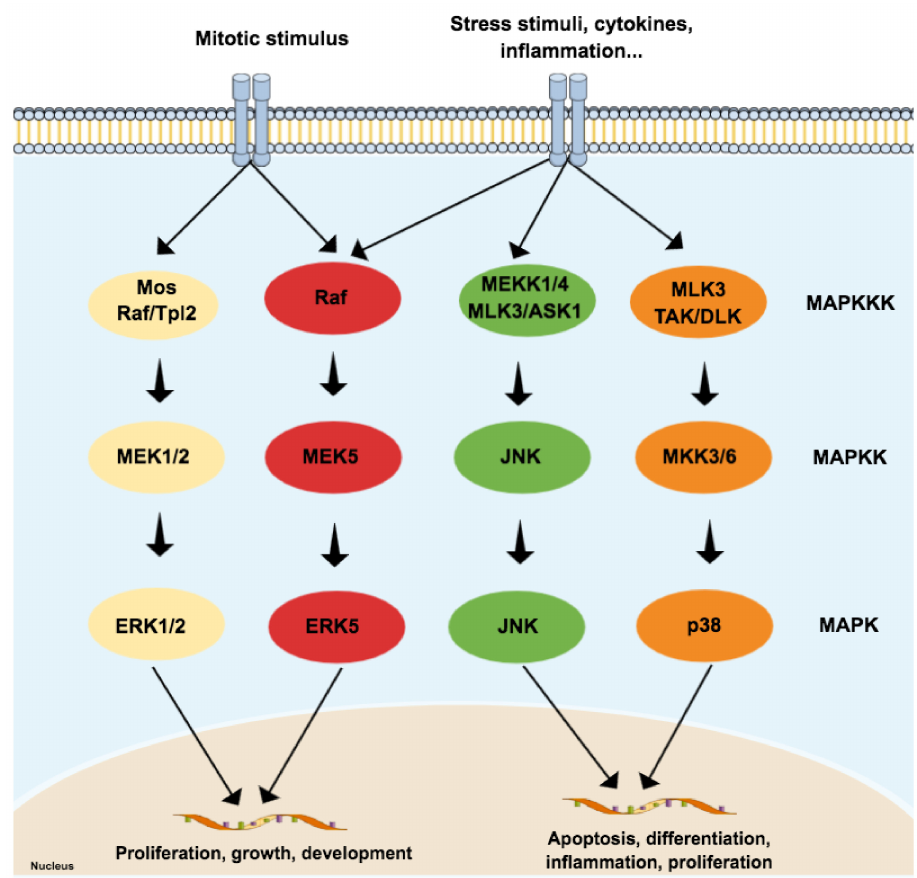
Figure 1. Schematic representation of the typical mitogen-activated protein kinases (MAPK) pathway, composed of three levels (three-tier module) and four subfamilies: extracellular signal-regulated kinases (ERK) 1 / 2, p38, c-Jun N-terminal kinase (JNK), and ERK5. Each subfamily regulates di ff erent phenotypes. While the canonical ERK subfamily (ERK1 / 2) responds to mitotic stimuli and controls cellular di ff erentiation and proliferation, JNK and p38 are activated by stressor stimuli and are involved in apoptosis. Since the ERK5 subfamily responds to both mitotic and stressor stimuli, being associated with cell survival, it is presented in a special